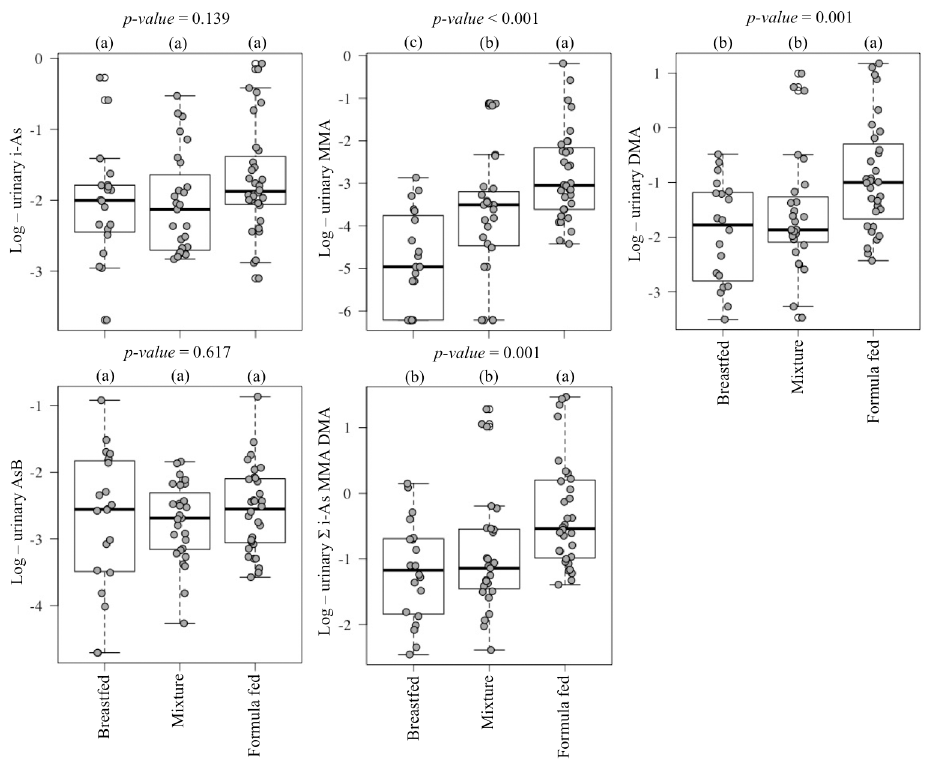
Fig 1. Urinary As species natural log concentrations according to the feeding mode before weaning (Values with the same letters were not significantly different at p -value < 0.05 for the variable studied).